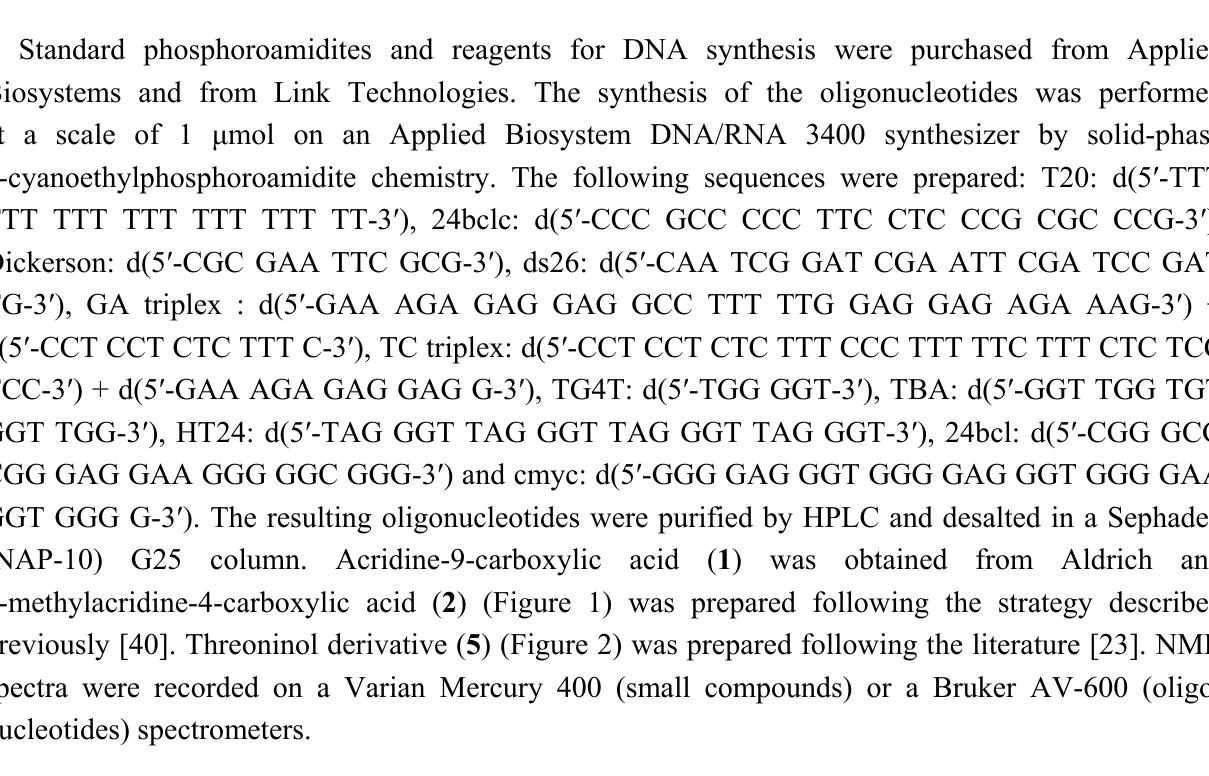
resulting from the titration of the duplex 2